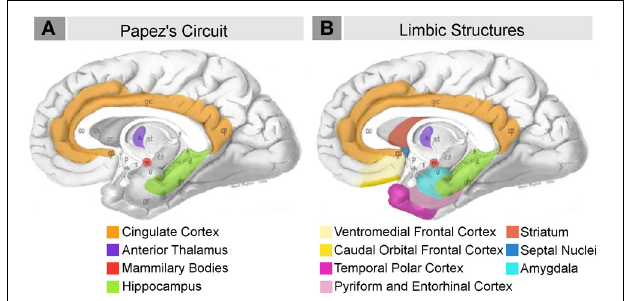
FIGURE 1 | Schematic briefly summarizing neural systems proposed to process emotion, highlighting structures that are visible on the medial surface of the brain. Papez’s (1937) original circuit (A) was expanded upon in the concept of the limbic system (B) to include a variety of subcortical and cortical territories (MacLean, 1952; Heimer and Van Hoesen, 2006). (Structures like the anterior insula and nucleus basalis of Meynert, which are not visible on the medial surface of the brain, are not represented here). Images modified from Papez’s (1937) original